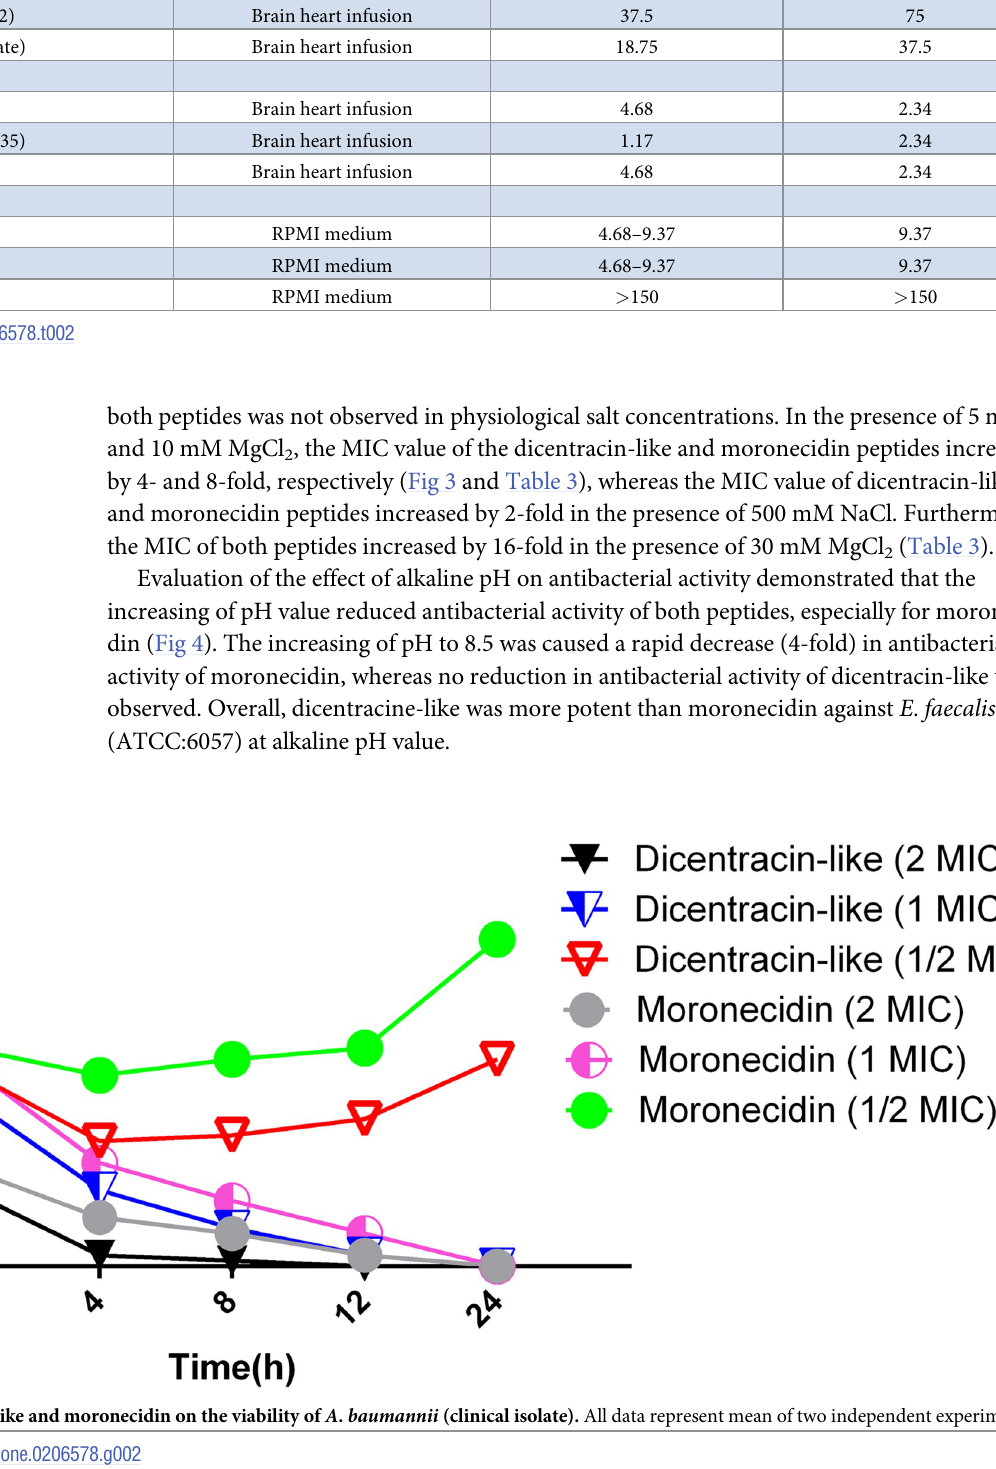
PLOS ONE | https://doi.org/10.1371/journal.pone.0206578 October 26,